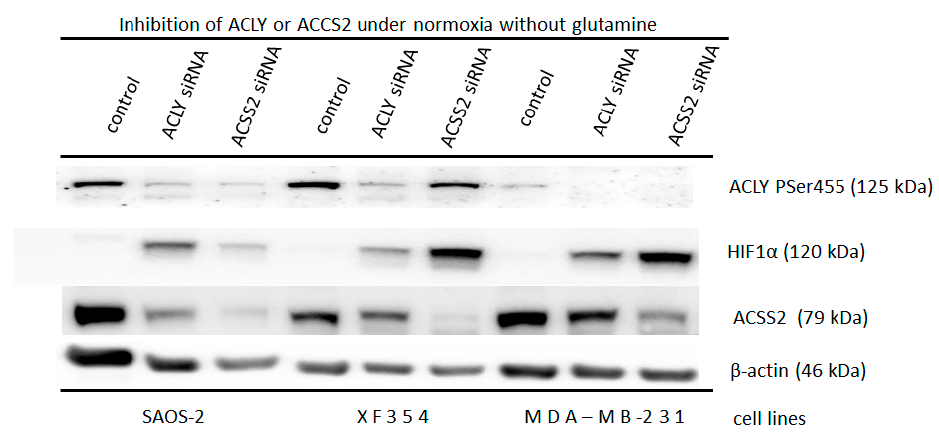
Figure 4. Glutamine independent induction of normoxic HIF1 α via down regulation of ACLY or ACSS2. Application of 20 nM siRNA against ATP citrate lyase (ACLY) or the cytosolic form of the